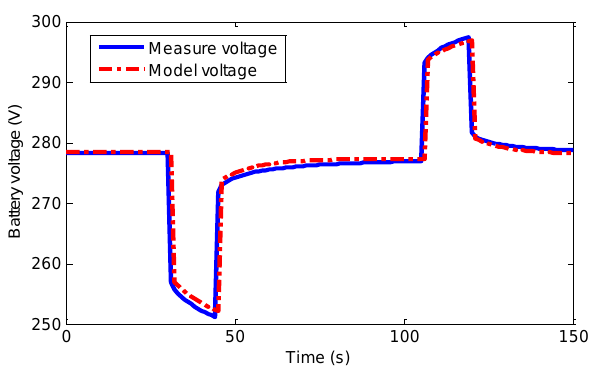
Figure 4. Voltage curve comparisons of the battery.